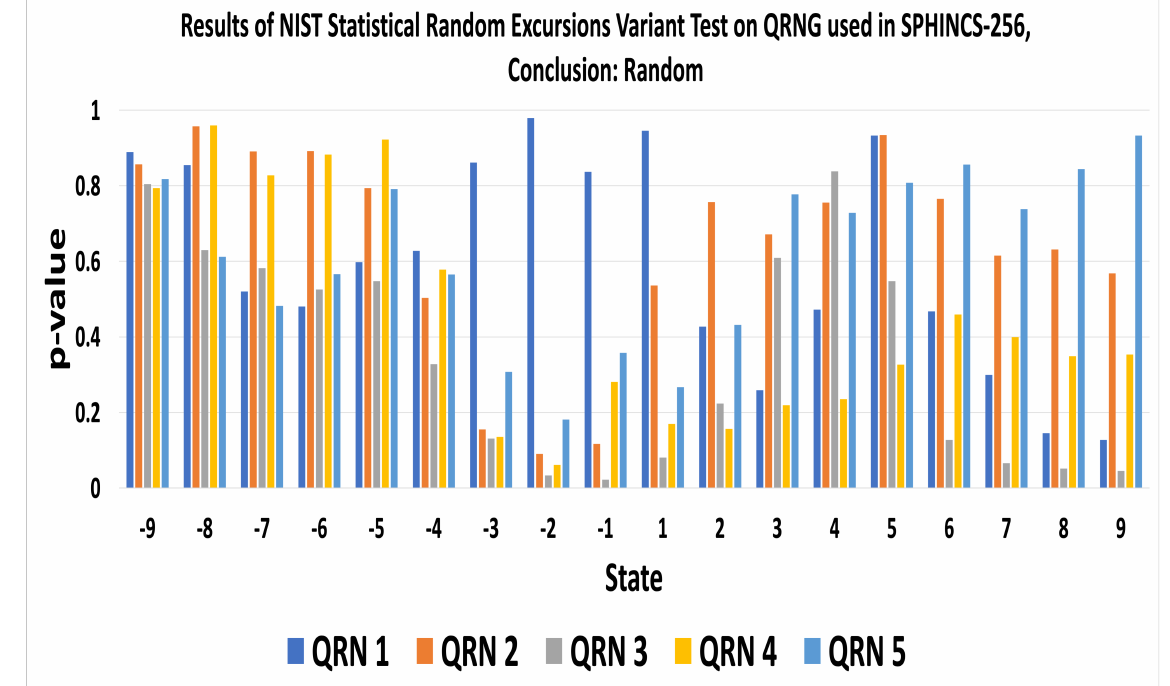
Figure 18. Results of Random Excursions Variant Test on Quantum Random Number Generator(QRNG) used in